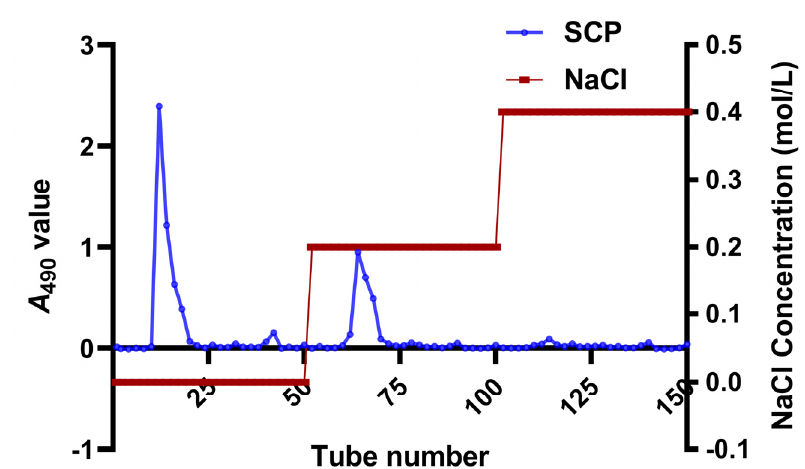
Figure 2. The elution curve of SCP on DEAE-52 cellulose column.